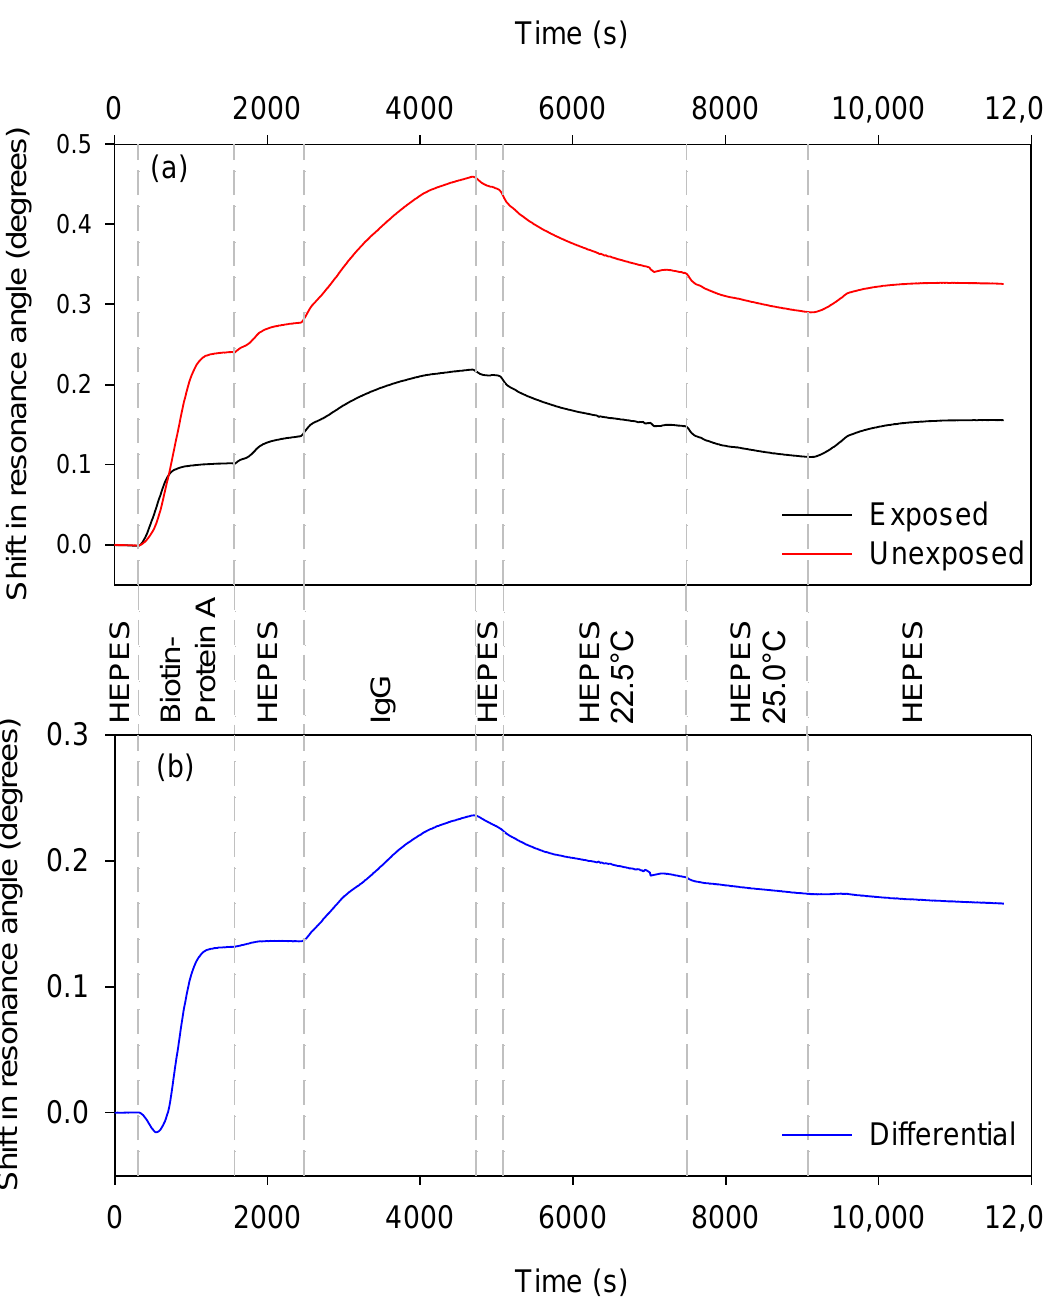
Figure 9. ( a ) Absolute and ( b ) di ff erential shifts in the resonance angles of the self-referenced di ff raction-based LW to protein A–biotin (PAB) (labelled as biotin-Protein A) and IgG binding and temperature changes during HEPES